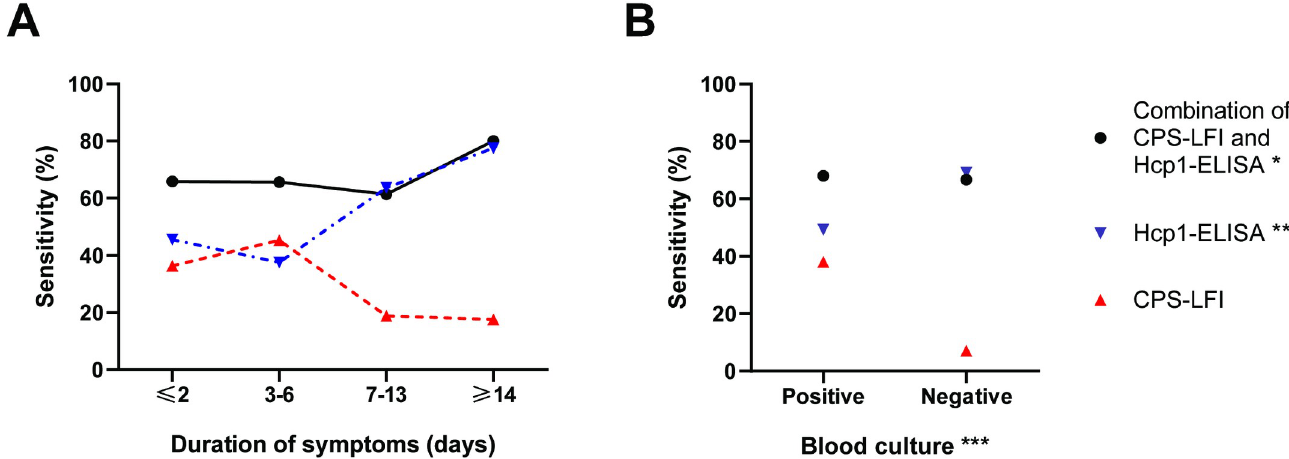
Fig 3. Sensitivity of the combination of the CPS-LFI and Hcp1-ELISA, Hcp1-ELISA alone and the CPS-LFI alone. (A) by duration of symptoms prior to admission and (B) by blood culture results in 192 melioidosis cases. � using OD cut-off value at a specificity of 95% (OD 2.912) �� using OD cut-off value at a specificity of 95% (OD 2.758) ��� Blood culture positive for B . pseudomallei .